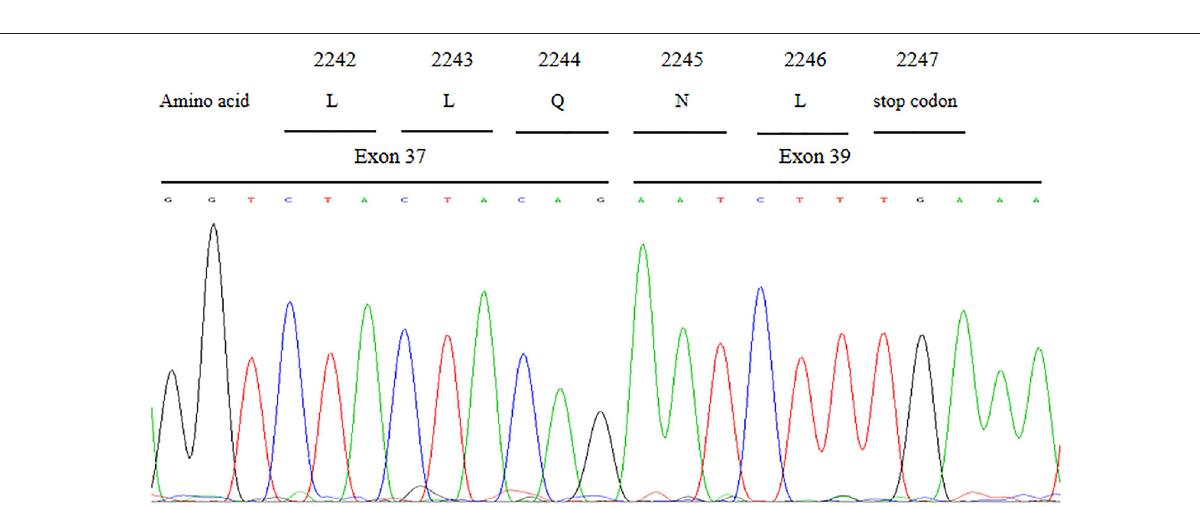
according to the ACMG guideline classification. Genetic